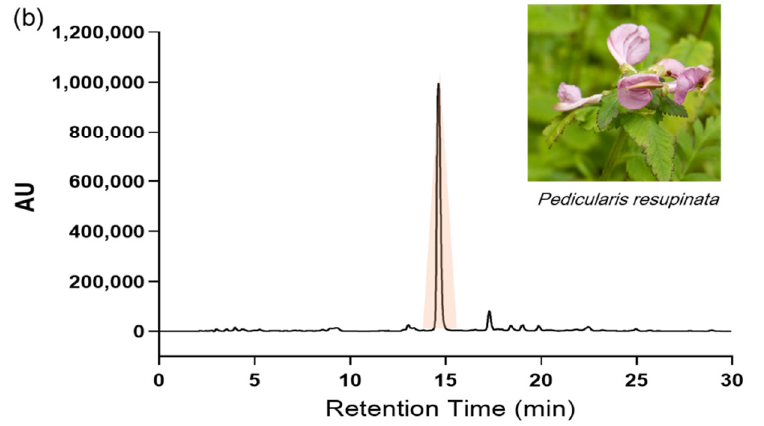
Figure 6. HPLC chromatogram of ( a ) acteoside as a standard compound and ( b ) Pedicularis resupinata extract. The concentration of acteoside was 0.78 ± 1.15 mg/g PRE.